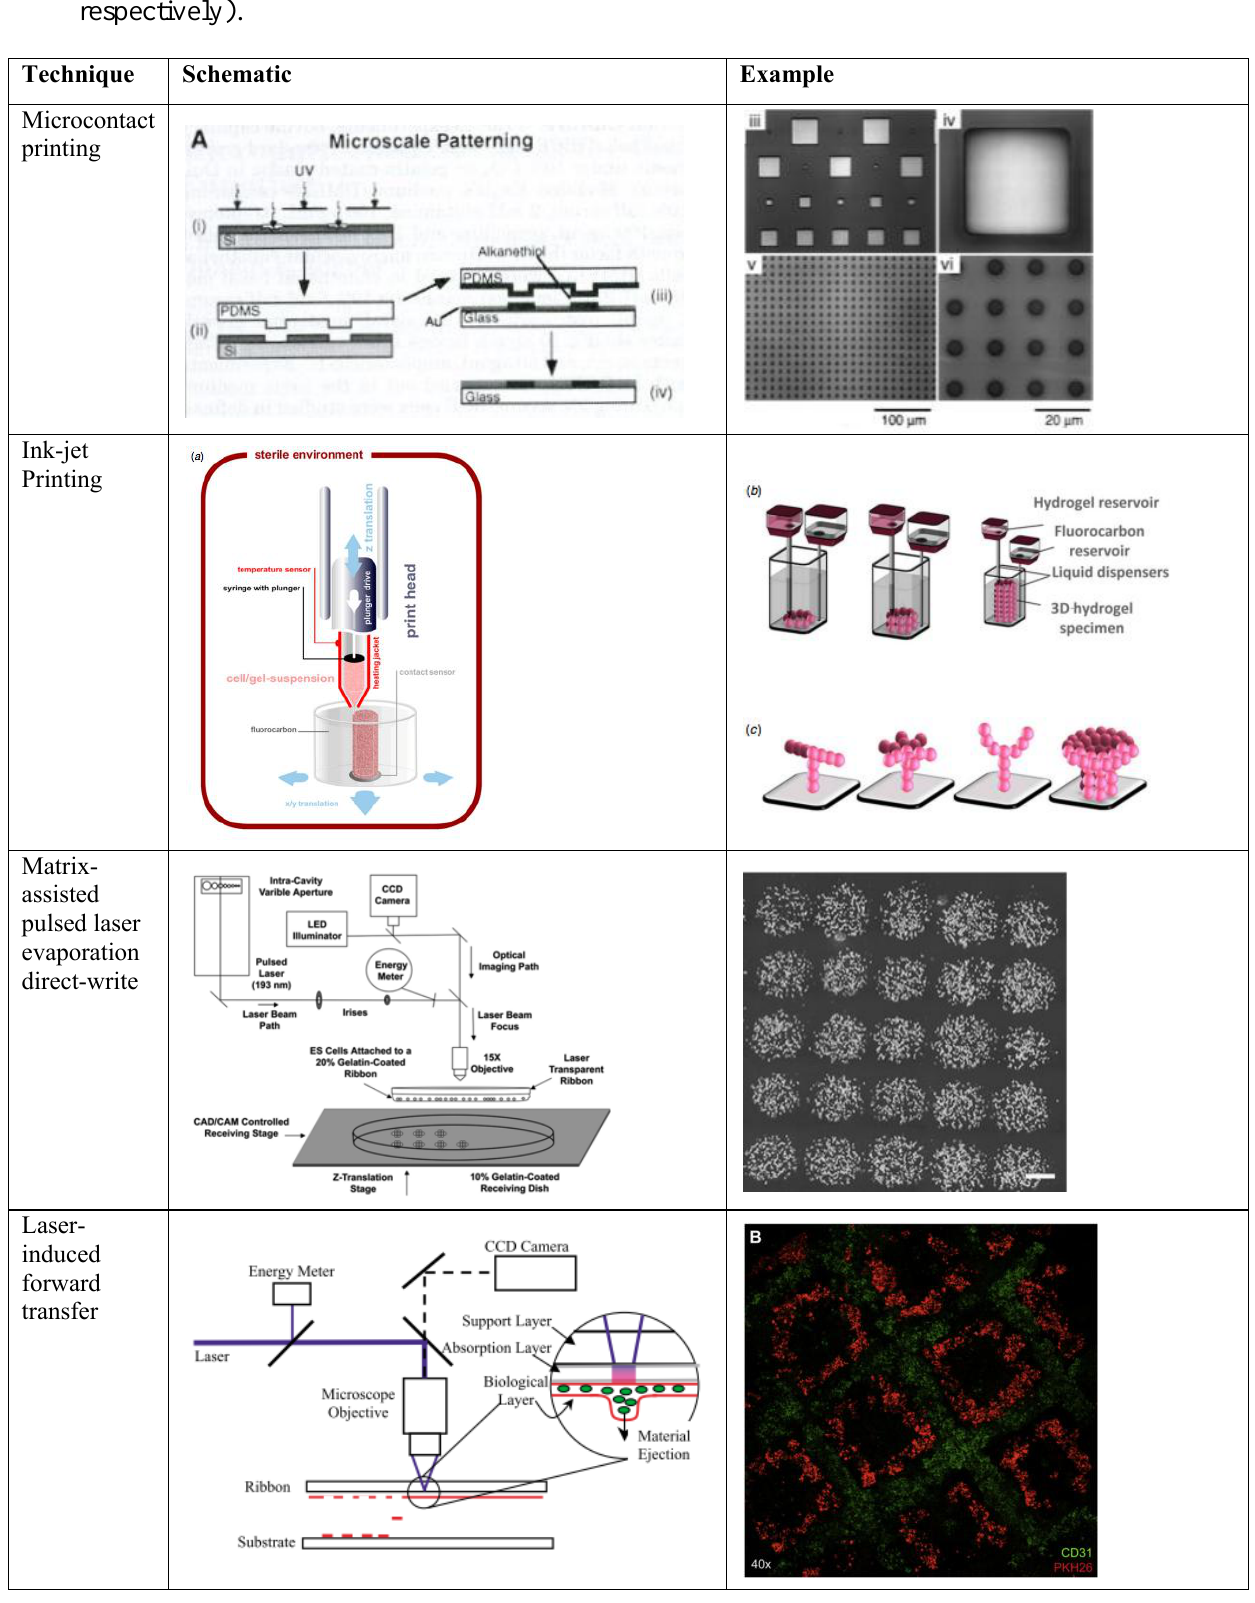
Figure 2. Schematics and examples of selected biofabrication patterning techniques, including microcontact printing [72], inkjet printing [73], MAPLE-DW [74], and LIFT [75,76] (Used with permission from John Wiley and Sons [72]; ©2013 IOP Publishing, reproduced with permission, all rights reserved [73]; used with permission from Elsevier [63,74–76],